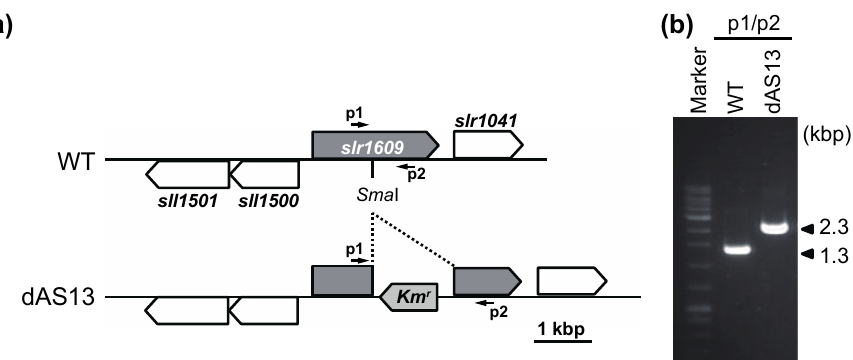
Figure 5. Construction of the aas insertional mutant (dAS13) of Synechocystis . ( a ) Diagrams showing the maps of the aas loci of the wild-type (WT) and the mutant (dAS13) Synechocystis. The arrows indicate the PCR primers p1 (5 ′ -AAGGGGTGATGCTCAGCCACGG-3 ′ ) and p2 (5 ′ -TTGGGTTACCACTGGTCGTTTGAGC-3 ′ ) used to screen for homozygous strains in the aas locus. The primers amplify 1.3 kb and 2.3 kb DNA fragments from the Synechocystis WT strain and the dAS13 mutant, respectively. ( b ) PCR analysis of the aas region of WT and dAS13. The primer pair p1/p2 was used for PCR and the products were analyzed by electrophoresis on a 1.0% agarose gel.